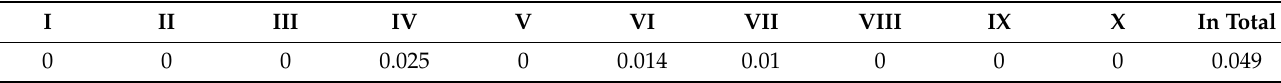
Table A4. Results by items (Service Development Area).